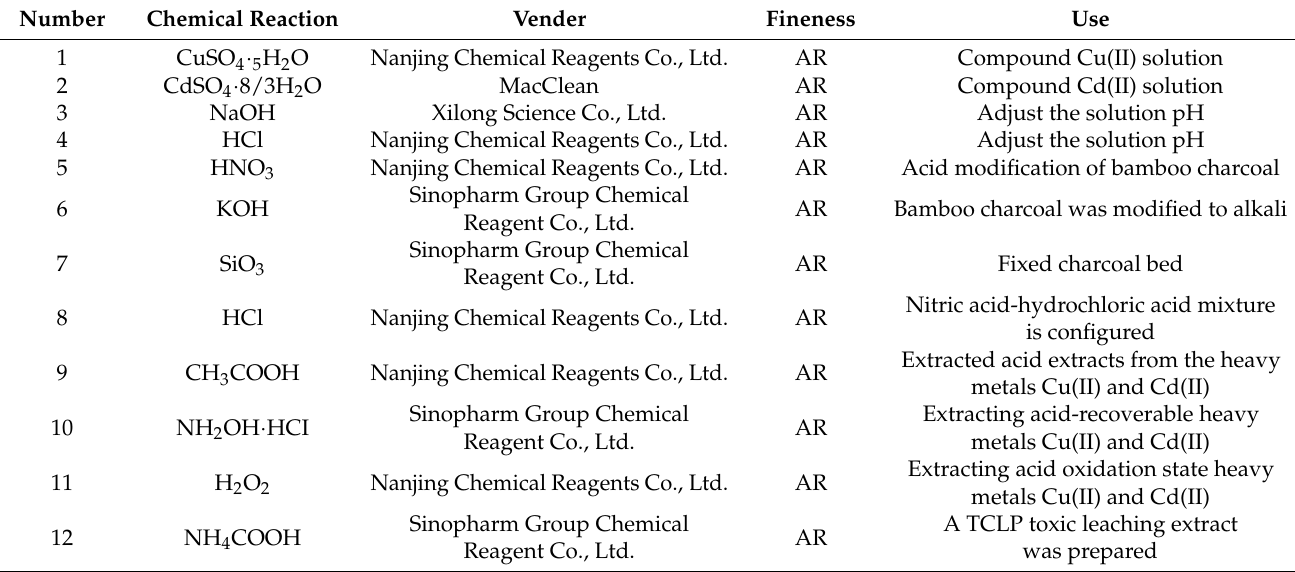
Table 3. Experimental